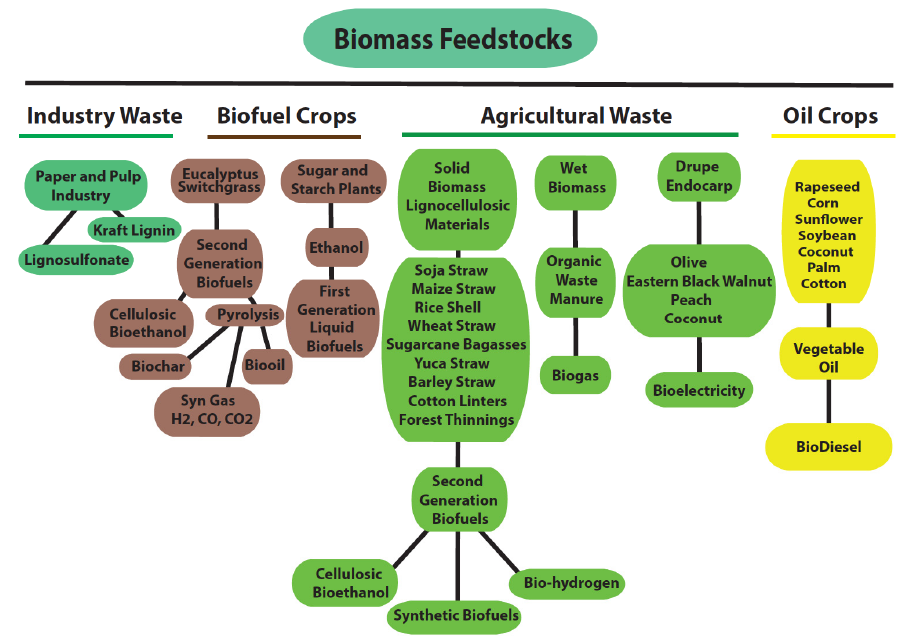
Figure 1. Biomass feedstocks and their utilization in the production of biofuels,